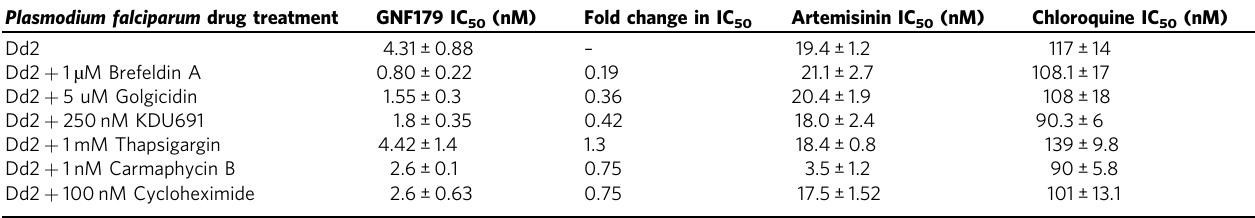
Table 4 Seventy-two-hour SYBR-green IC 50 s for the indicated compound combinations including GNF179. Plasmodium falciparum drug treatment